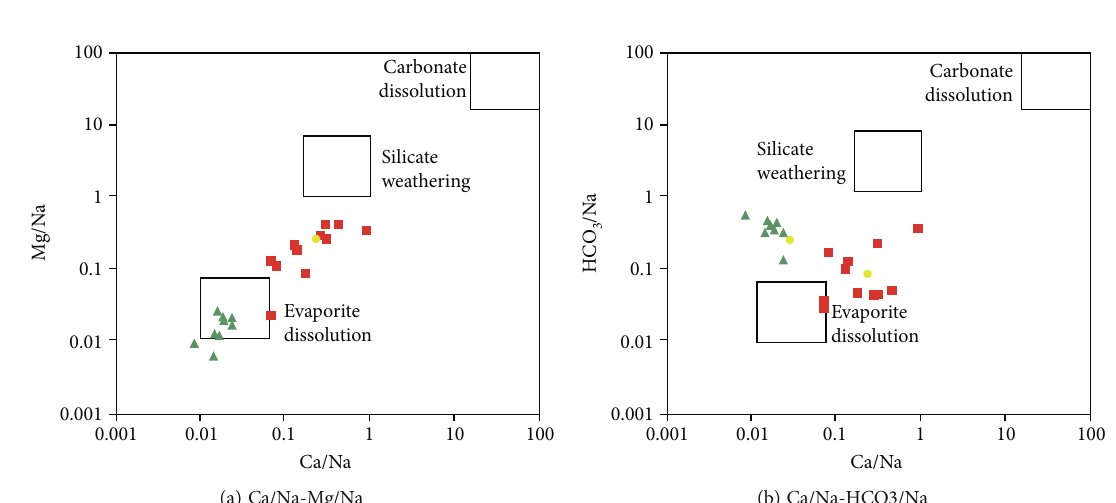
Figure 4: Gibbs diagram.